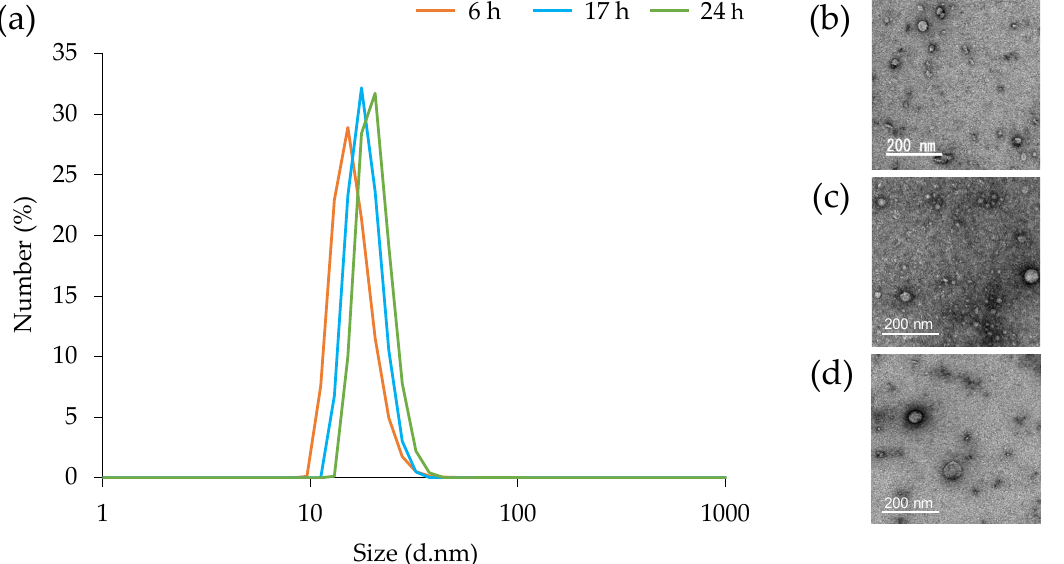
Figure 3. Particle size distribution of membrane vesicles (MVs) derived from Staphylococcus aureus . ( a ) The particle size distribution of MVs prepared from the culture supernatant after incubation for 6, 17, and 24 h. The average size distribution of the MVs was determined using dynamic light scattering. TEM images of MVs prepared from culture supernatants after incubation for 6 ( b ), 17 ( c ), and 24 h ( d ).